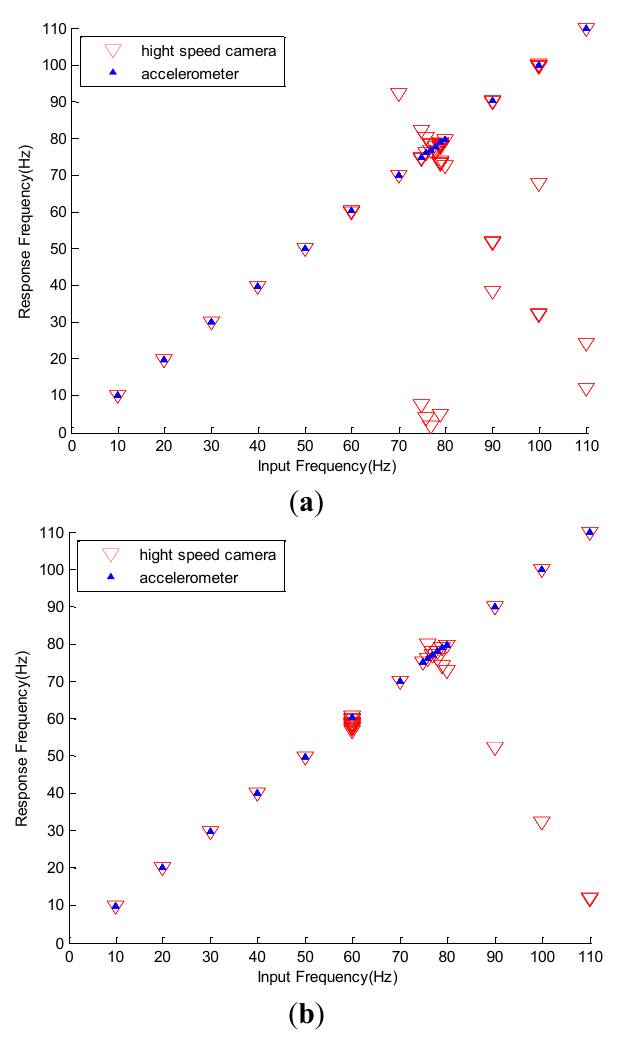
Figure 11. Significant modes captured by the high speed camera and accelerometer: ( a ) the amplitude of the exciter’s vibration is 0.536 mm. ( b ) the amplitude of exciter’s vibration is 0.371